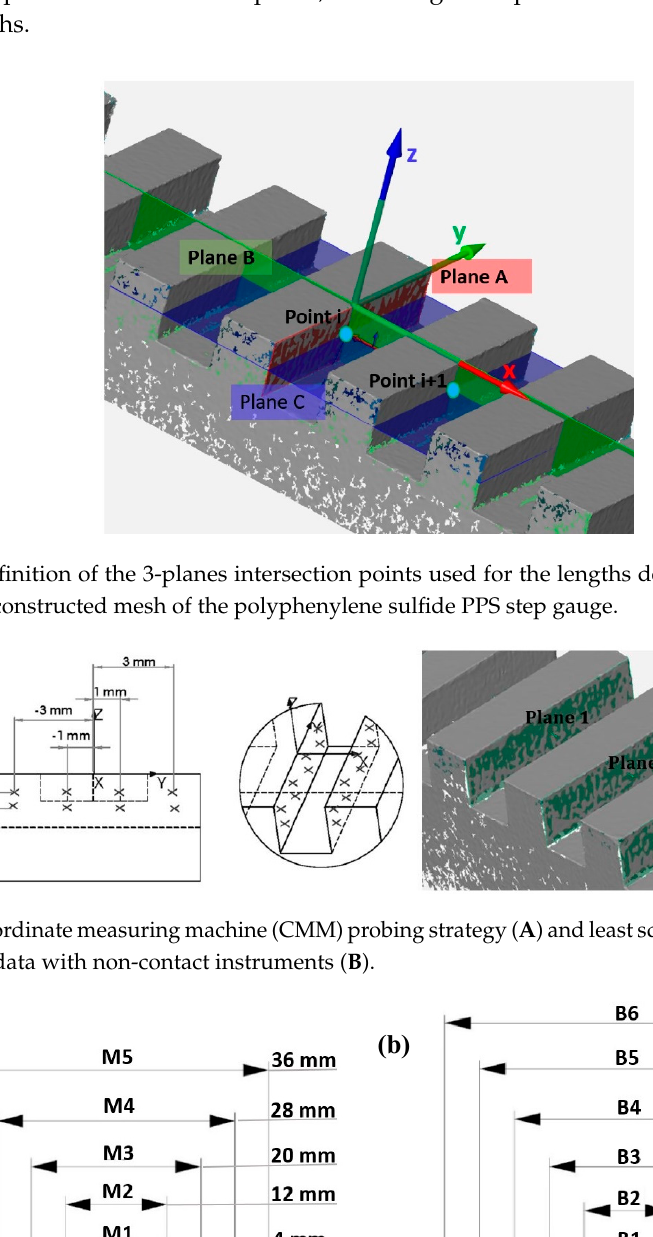
Figure 3. Coordinate measuring machine (CMM) probing strategy ( A ) and least square fitting procedure on acquired data with non-contact instruments ( B ).